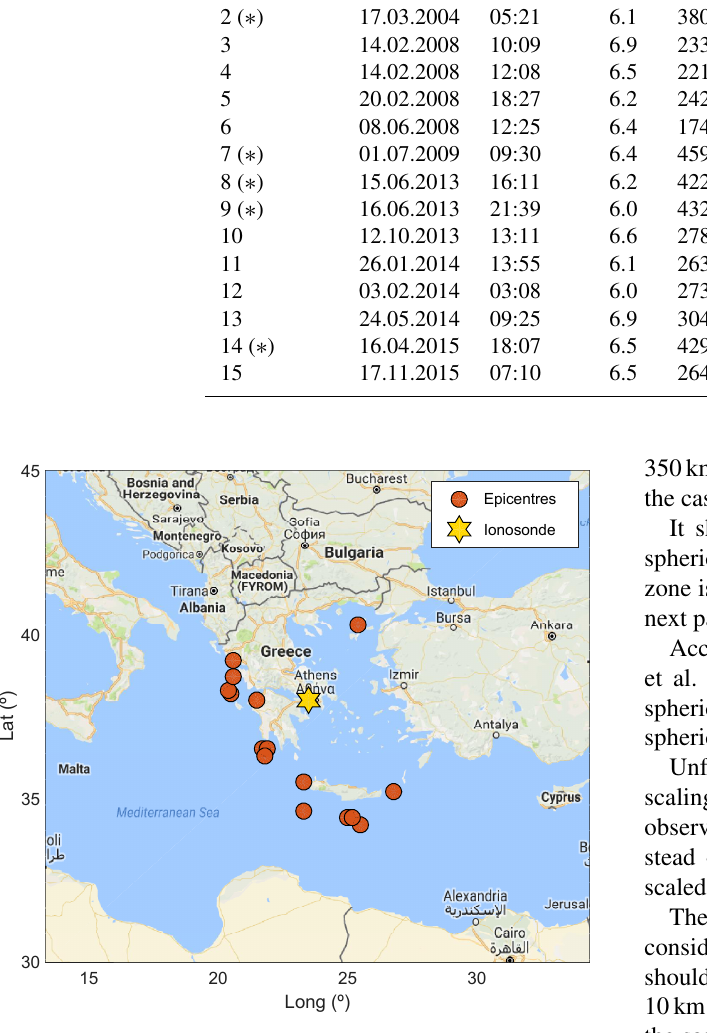
Figure 1. Epicentres of major earthquakes in Greece and surround- ing area ( M ≥ 6, depth < 50km) between January 2003 and De- cember 2015 and the ionosonde